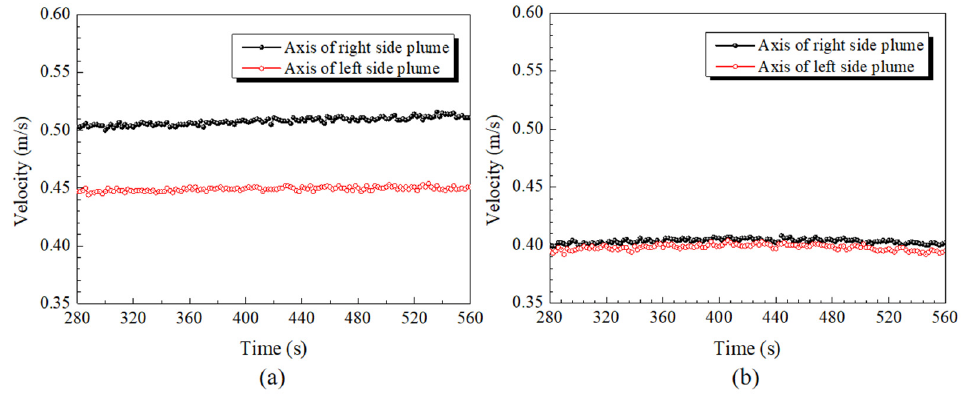
Figure 8. Comparison of velocity on the axis of plume zones: ( a ) S–P mode, ( b ) P–P mode.